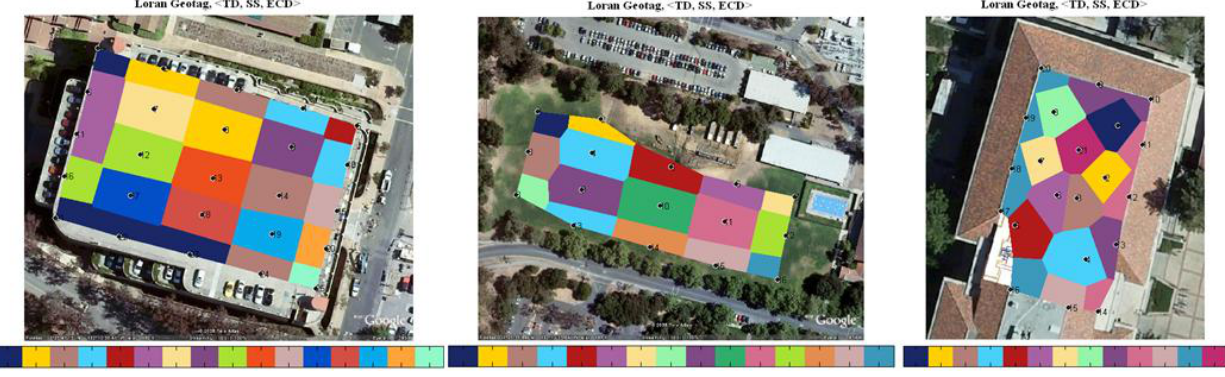
Figure 4. Visualization of location tags: (a) parking structure (left); (b) soccer field (middle); (c) Durand building